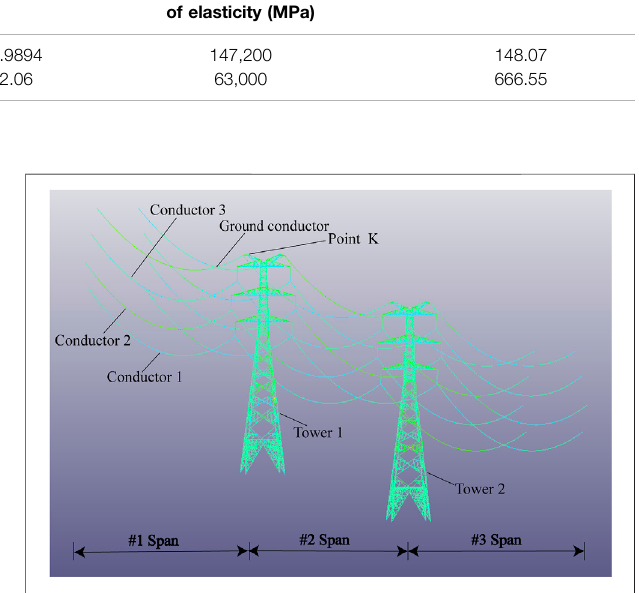
FIGURE 3 | Finite element model of the transmission tower-line